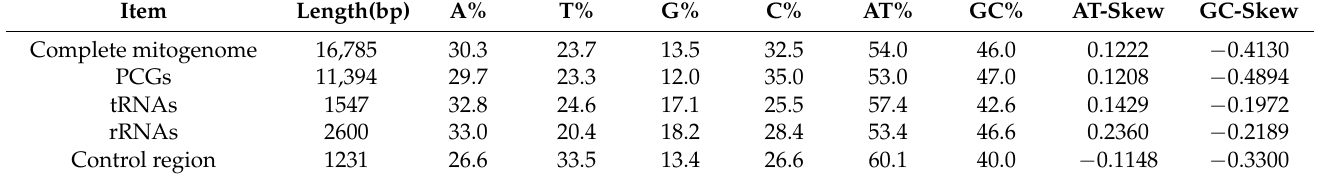
Table 2. Nucleotide composition in different regions of the mitochondrial genome of the Pingpu Yellow chicken.